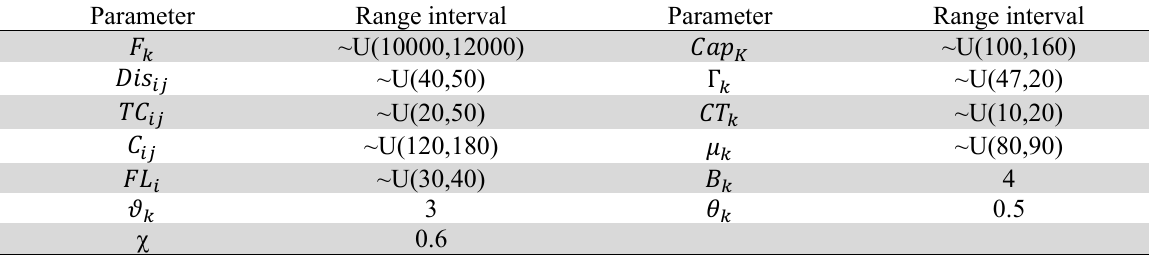
The boundaries of the parameters produced on the basis of uniform distribution Parameter Range interval Parameter Range interval 𝐹